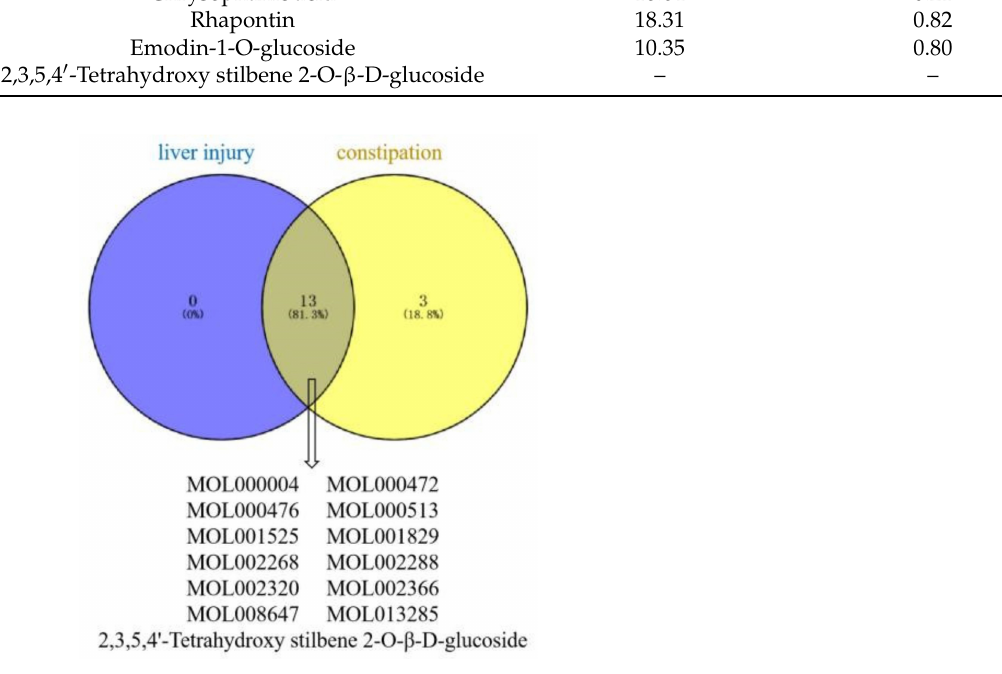
Figure 9. Venn diagram of constituents of PM for liver injury and constipation.